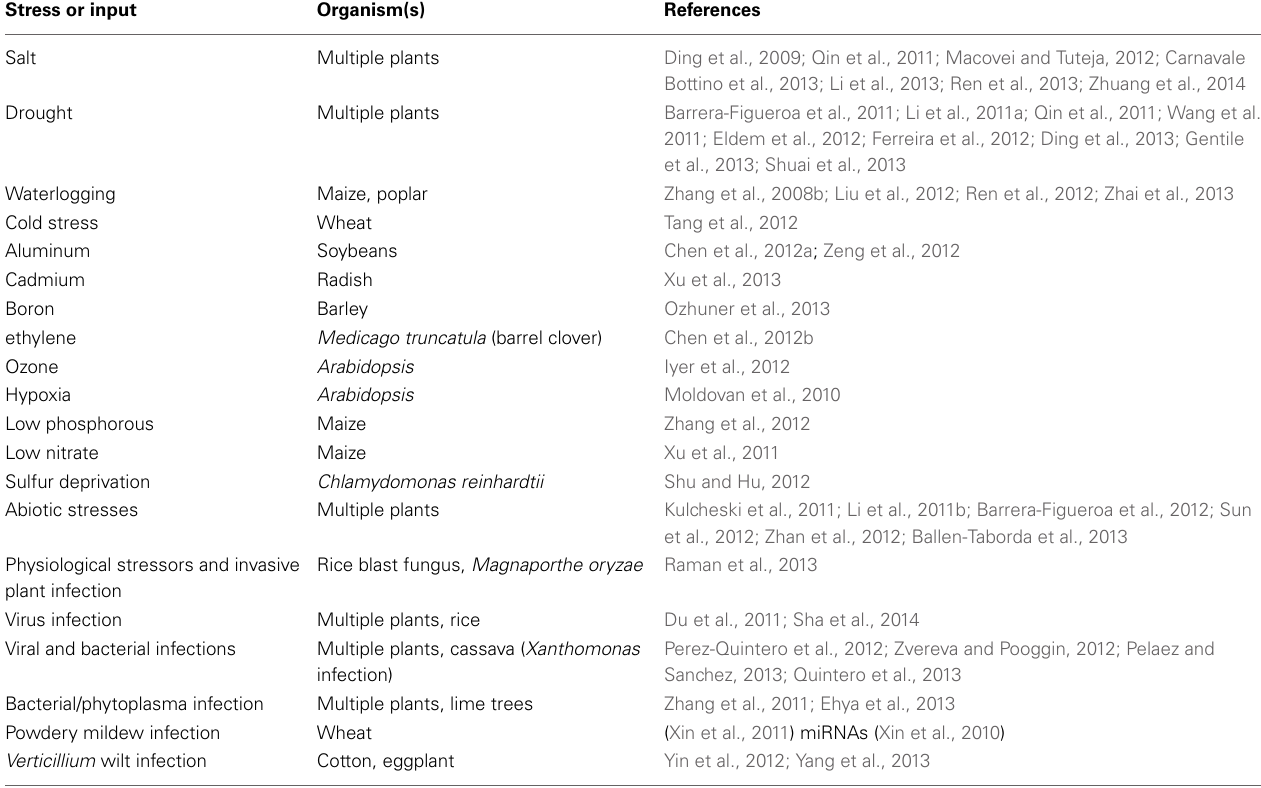
Table 4 | Changes in non-coding RNAs in response to life history